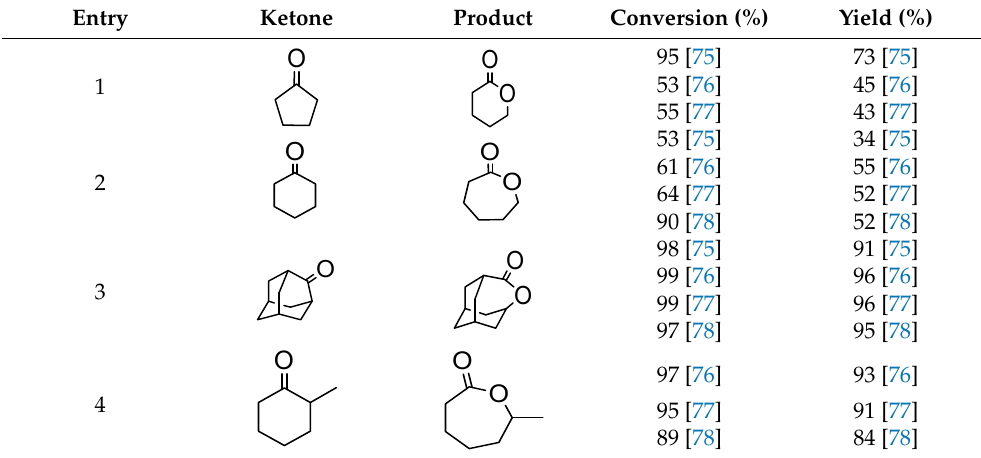
Table 8. Oxidation of cyclic ketones to lactones.